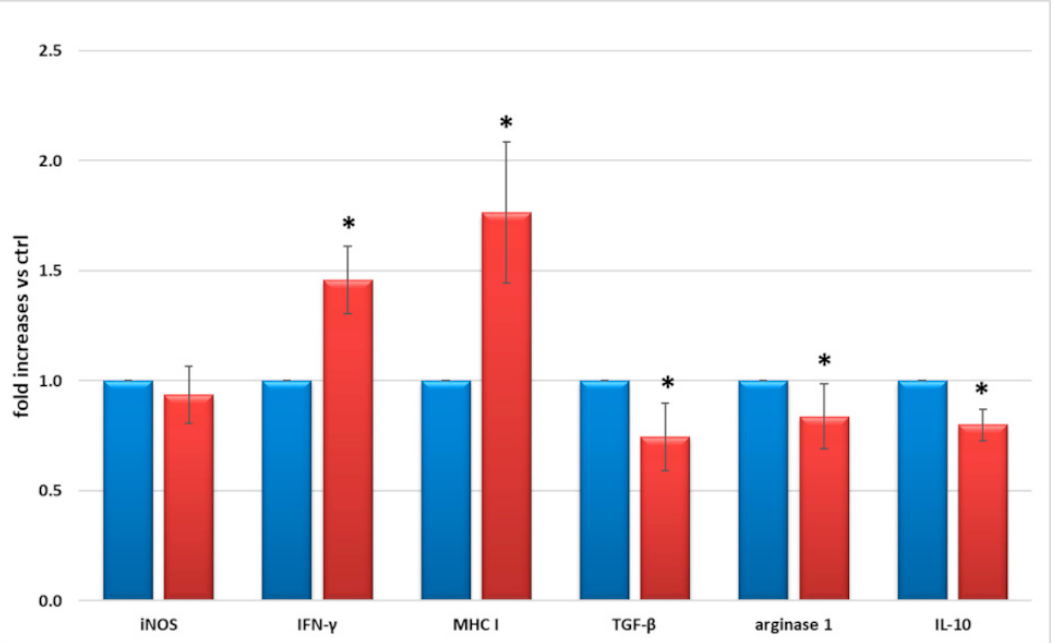
Figure 3. Protein expression of iNOS, IFN- γ , MHC I (pro-inflammatory markers), TGF- β , arginase 1, and IL-10 (anti-inflammatory markers), measured by Western blotting in lysates of cells cultured in control conditions (blue) and after M1 activation (red). M1 activation was achieved by exposing microglial cells for 24 h to TNF- α 10 ng/mL + IL-1 β 20 ng/mL + IFN- γ 50 ng/mL. Mean of five experiments ± SD, * p < 0.05.